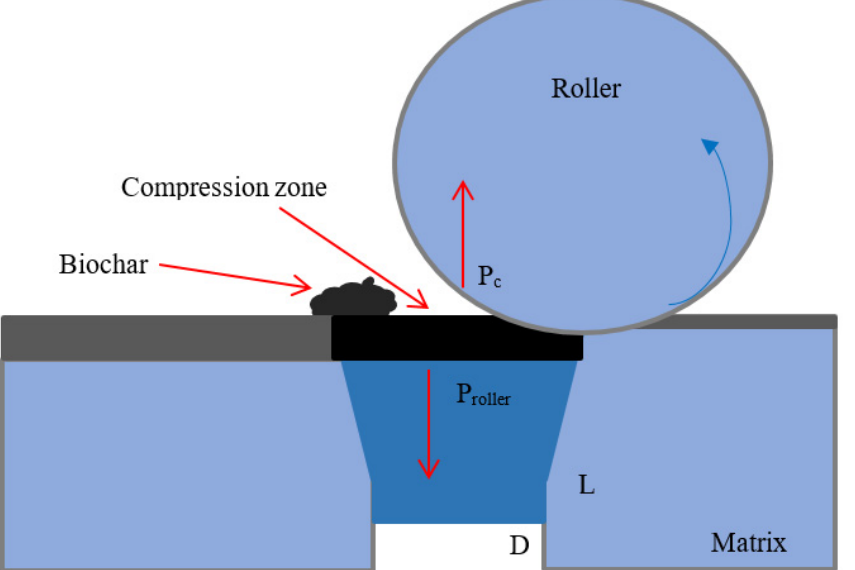
Figure 2. The principle of the process of pelletization with rotating and fixed matrix. D and L are the diameter and length of the die, while P roller and P c respectively represents the pressure generated by the roller on the pelletized biochar, and the compressive pressure of the pelleting process. Reproduced with permission from [14].